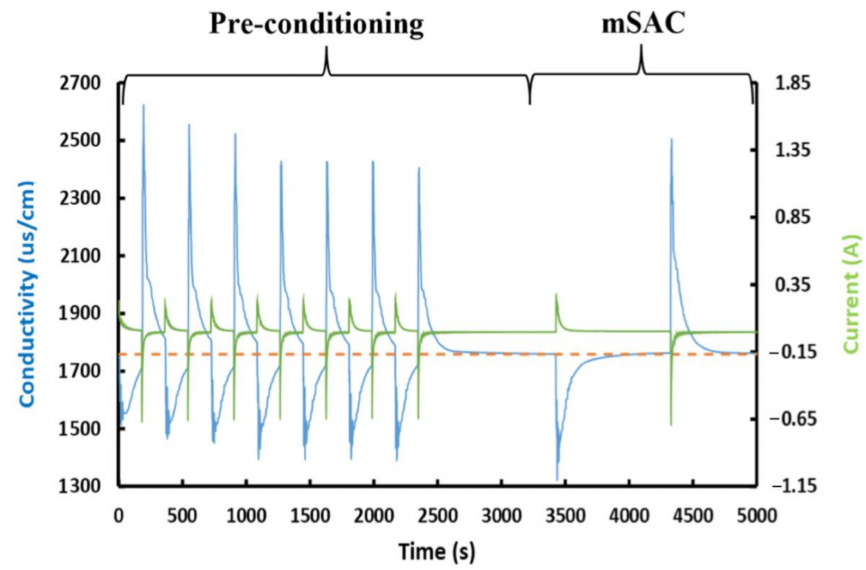
Figure 6. Conductivity of solution entering and exiting the membrane capacitive deionisation (MCDI) cell (dashed line: orange and solid line: blue, respectively) and the current generated (solid line: green) as a function of the applied electrode potential over time for electrode E1. The maximum salt adsorption capacity (mSAC) is a measure of the maximum amount of salt adsorbed on an electrode in mg per gram (mg/g) of electrode used in the cell.